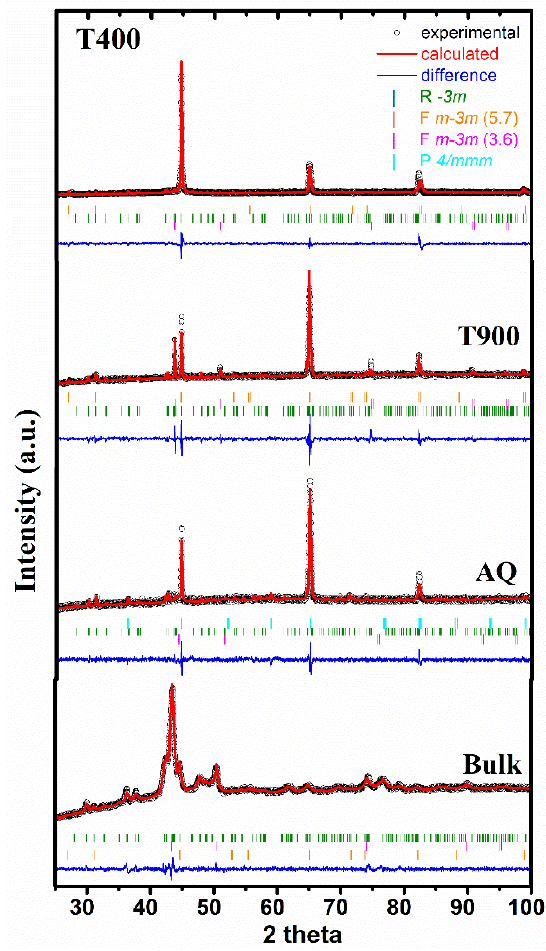
Figure 2. XRD spectra recorded at RT. Table 2. Crystalline phases and lattices parameters, extracted from XRD data Sample